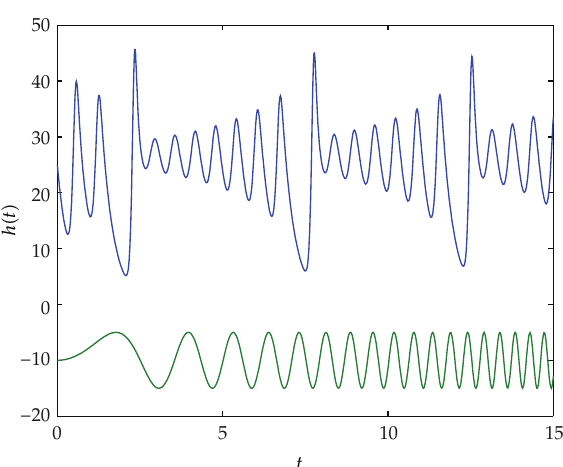
Figure 6: Real message of h (cid:3) t (cid:4) ∈ (cid:6) 2 × 1 described in the transmitter of (cid:3) 3.6a (cid:4) – (cid:3) 3.6f (cid:4) .